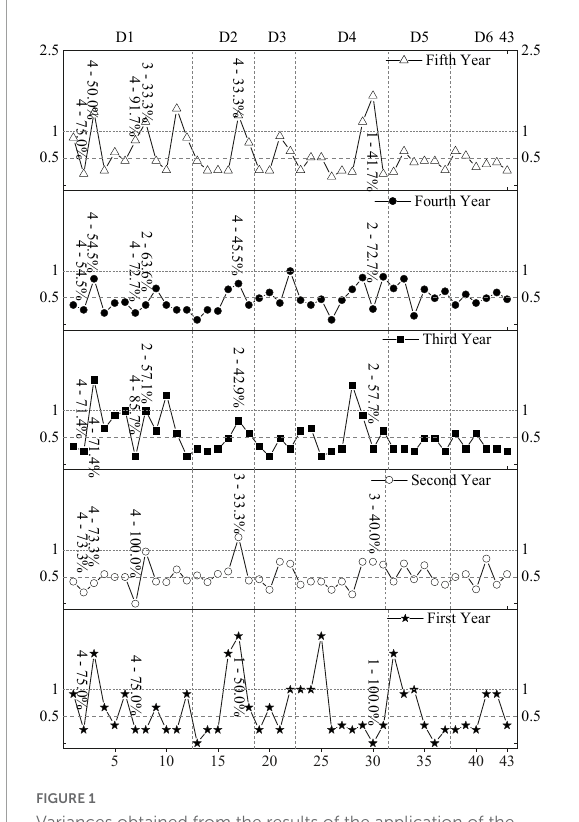
FIGURE1 Variances obtained from the results of the application of the digital competence questionnaire for higher education students (CDAES) according to the year of career progression of pedagogy in chemistry.